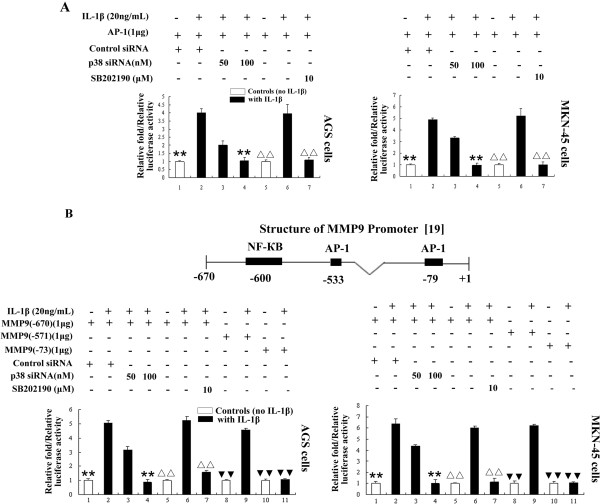
IL-1β activates AP-1 activity through p38 pathway. A: Both GA cells were transfected with AP-1 reporter plasmid or AP-1 reporter plasmid together with scramble siRNA or p38 siRNA. AP-1 luciferase reporter gene activity was significantly increased by IL-1β stimulation in both AGS and MKN-45 cells; these effects were significantly inhibited by p38 siRNA in a dose-dependent manner and also inhibited by the p38 inhibitor SB202190. ** P < 0.05 vs. control siRNA (scramble siRNA) + AP-1 luc-transfected cells stimulated with IL-1β; ΔΔP < 0.05 vs. AP-1 luc-transfected cells stimulated with IL-1β; relative luciferase activity was normalized to B-gal. B: IL-1β-induced p38-mediated activation of the MMP9 promoters is dependent on the AP-1-binding sites. ** P < 0.05 vs. transfected −670/MMP9 + control siRNA cells stimulated with IL-1β; ΔΔP < 0.05 vs. transfected −670/MMP9 cells stimulated with IL-1β; ▼▼P < 0.05 vs. transfected −570/MMP9 cells stimulated with IL-1β; relative luciferase activity was normalized to B-gal.